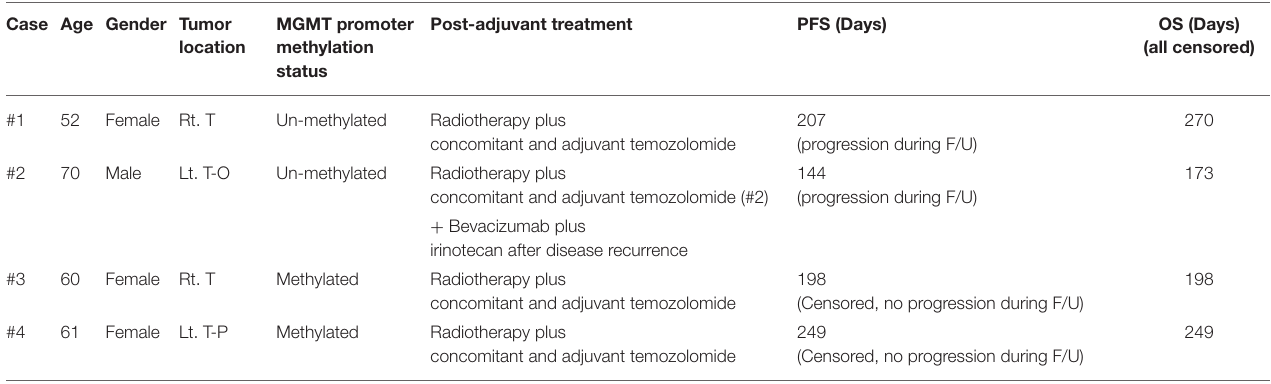
TABLE 1 | Clinical characteristics of four glioblastoma patients. Case Age Gender Tumor location